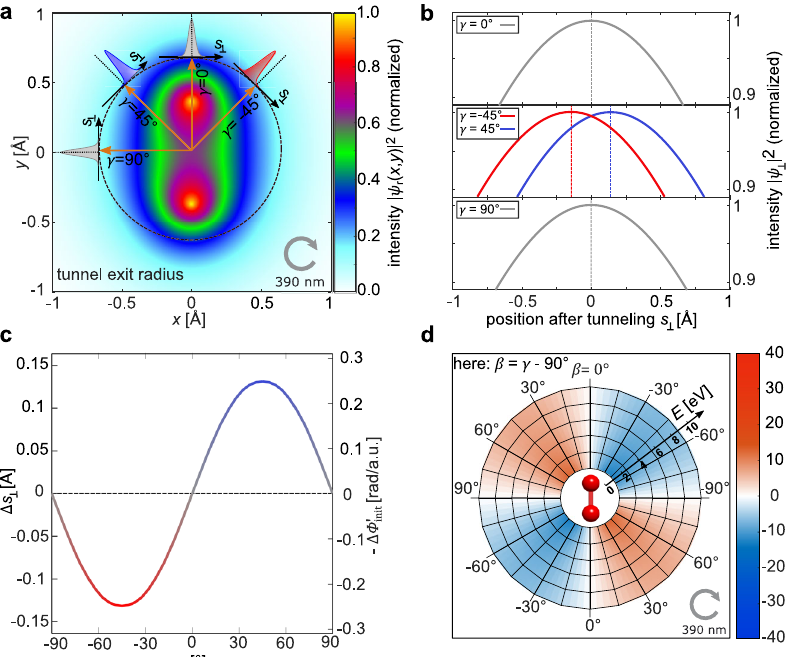
Fig. 1 Origin of the dependence of the Wigner time delay on the molecular orientation for strong- fi eld ionization. a Two-dimensional distribution (cid:4) (cid:4) (cid:4) (cid:4) 2 of the molecular orbital of H ψ x ; y ð Þ r 2 in position space. Different tunneling directions (orange arrows, de perpendicular directions (black arrows, labeled with s ? ) are indicated. The colored Gaussian curves allude to the dependence of the projection of ψ r x ; y ð Þ along s ? as a function of γ that is discussed in ( b , c ). The tunnel exit position that is used in ( a ) is chosen unrealistically short (about a factor of 12) for illustrational purposes (see “ Methods ” ). b One-dimensional cuts of the square of the wave function in position space along the four exemplary arrows labeled with s ? from ( a ). The position offset Δ s ? is zero for tunneling parallel or perpendicularly to the molecular axis ( γ = 0° and γ = ±90°) due to the symmetry of H 2 . Maximally positive [negative] values of Δ s ? appear for γ = 45° [ γ = − 45°]. c The position offset Δ s ? ð γ Þ of the one-dimensional cuts of the square of the wave function in position space along s ? . Note, that Δ s ? is equivalent to (cid:2) Δ ϕ 0 function of the electron energy E and β , which is the electron emission direction with respect to the molecular axis, are obtained using the curve from Δ ϕ 0 ( c ) and Δ τ W ; M ¼ _ m e j p (see Methods). Note that β ¼ γ (cid:2) 90 (cid:3) within the PFT model and that the width of the illustrated wave packets in ( a ) is not init elec j to